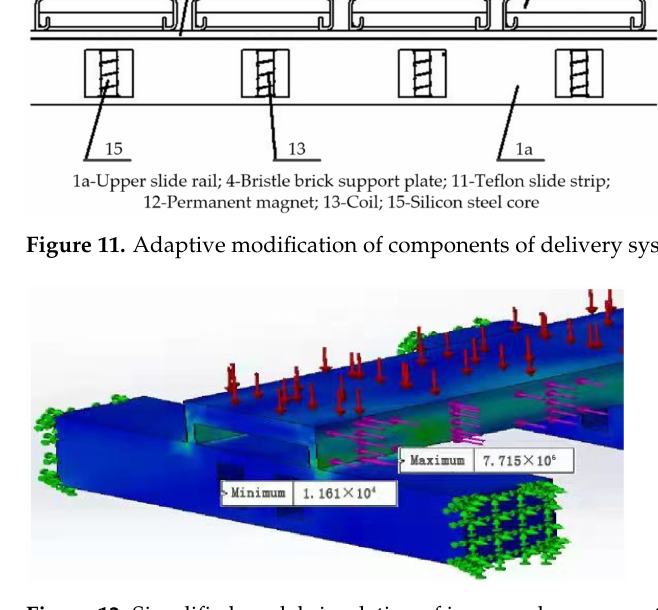
Figure 12. Simplified model simulation of improved components of delivery